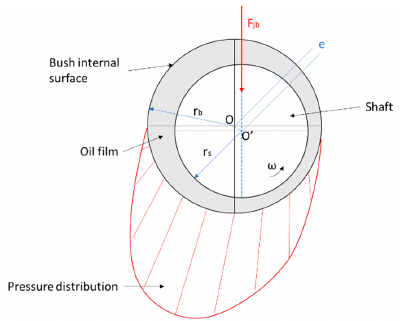
(b) Figure 5. Reference tooth subdivision. (a) Tooth region considered to calculate the lateral losses (b) same region in 3D representation with the frame of reference adopted The tooth has been split into a certain number of slices, and each of these portions of the gap is characterized by a reference height value h l , i that depends on the initial position of bushing in terms of central height h 0 and tilt t , as in Equation (14) and as shown in Figure 6: 𝒉 𝒍,𝒊 = 𝒉 (cid:2868) + 𝒕 (cid:3401) 𝒙